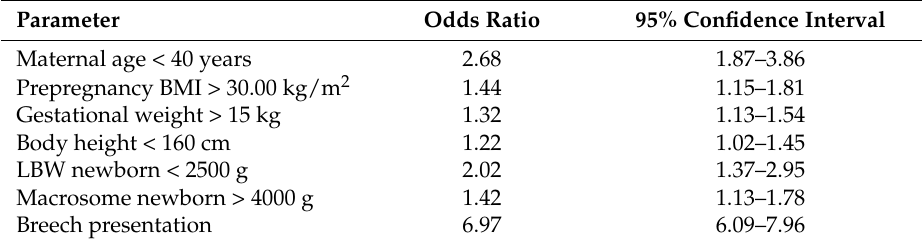
Table 5. Caesarean section risk factors.